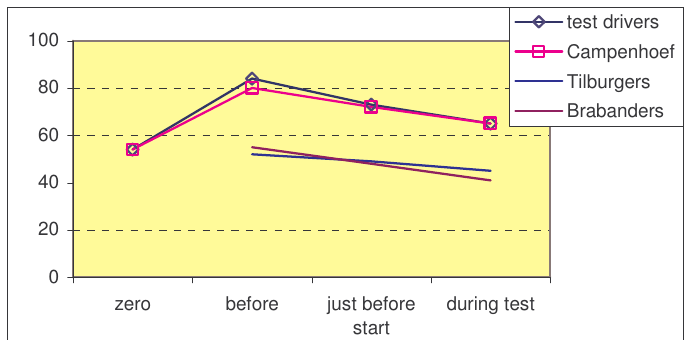
Figure 4. Development of ISA acceptance in test group and reference groups (n=120